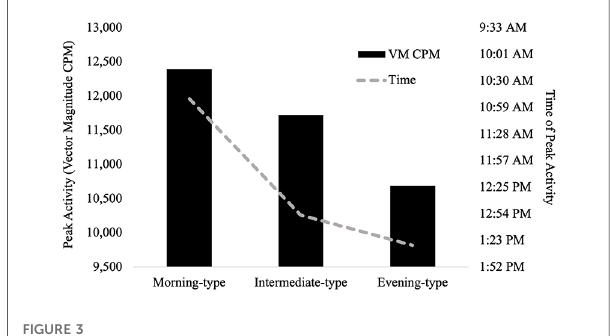
FIGURE 3 Differences in average peak activity and time of peak activity between chronotype groups.